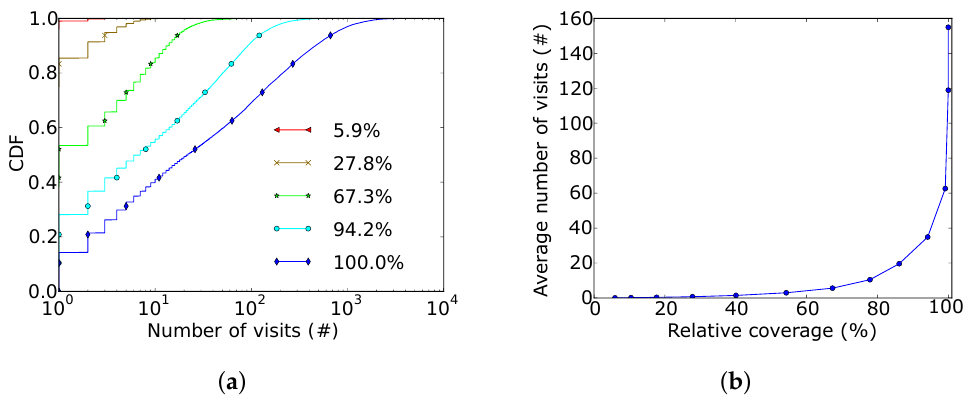
Figure 5. Sensing frequency of street sections throughout a day. ( a ) CDF of the amount of times the same street section was visited, for different coverage proportions; ( b ) average of times a street section was visited, as a function of the coverage